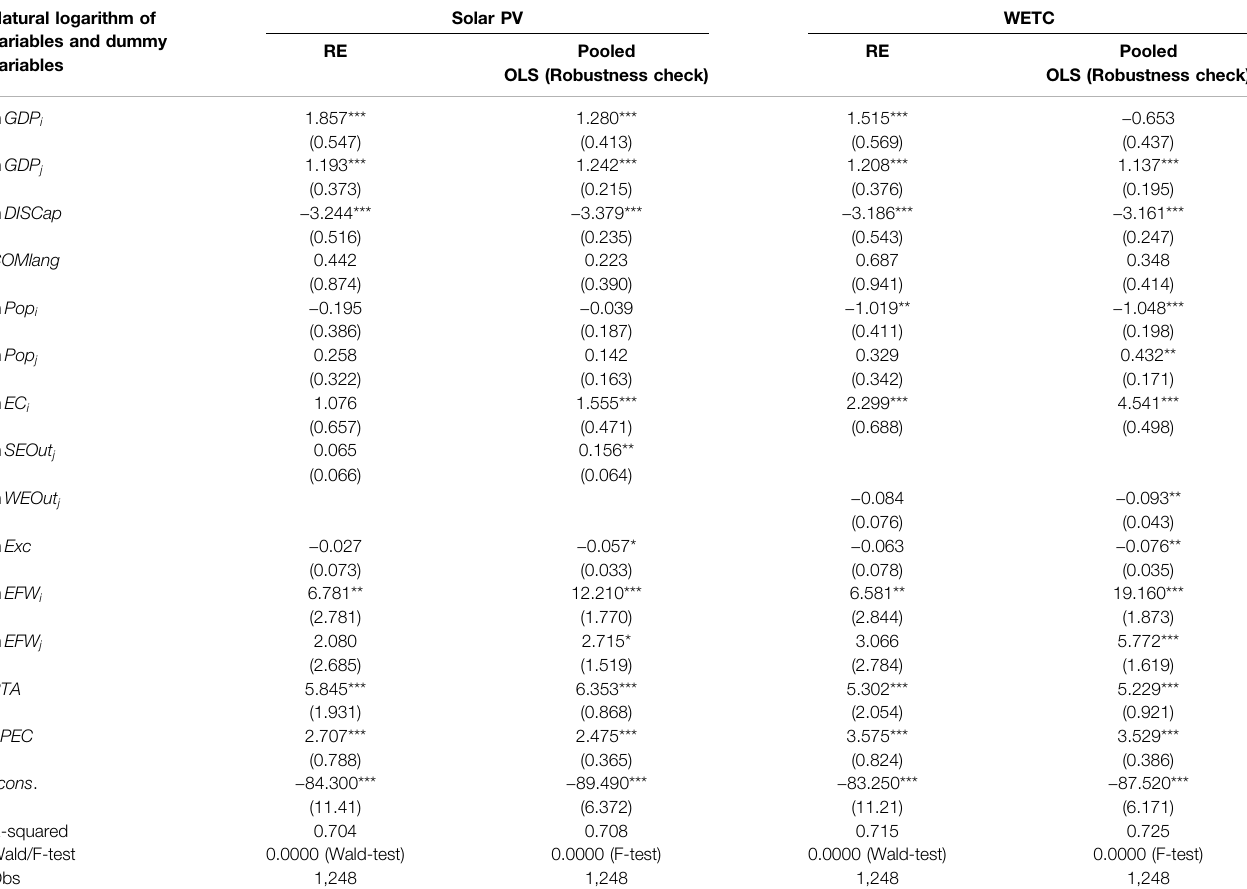
TABLE 6 | Separately estimated results for solar PV and WETC